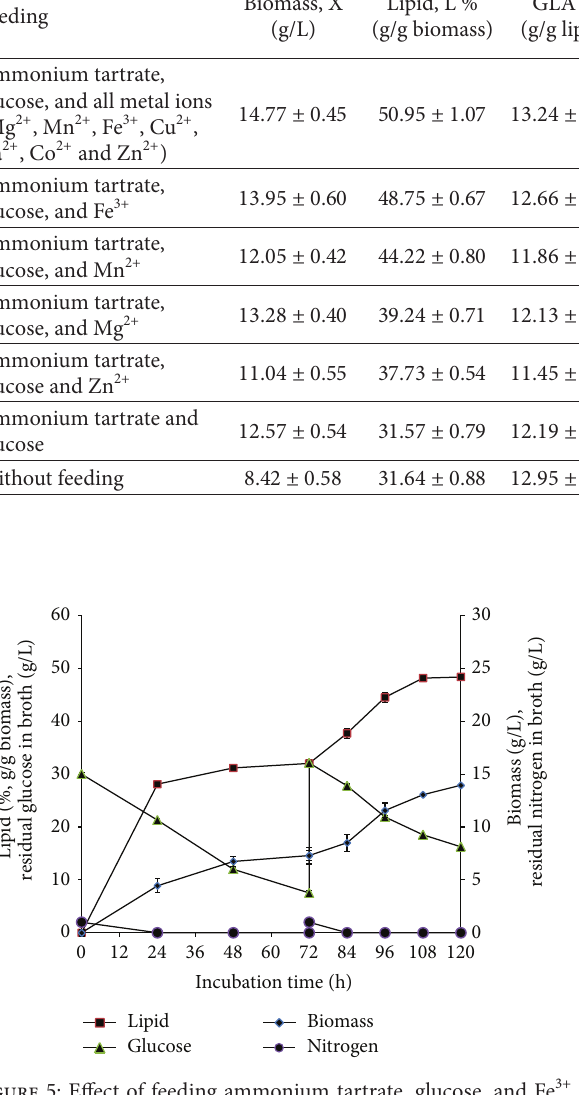
Table 1: Effect of feeding on lipid and GLA production. Cultures were fed with several medium components at 72 hours of cultivation. Lipid was extracted and analyzed for GLA content at 120hours of cultivation. The data represent means ± SDs, 𝑛 = 3 . Feeding